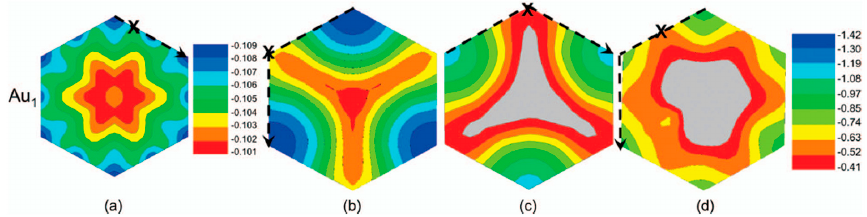
Figure 5. Potential energy surfaces for Au 1 on the (3 × 3) surfaces: ( a ) freestanding graphene; ( b ) graphene on fcc Ru(0001); ( c ) graphene on hcp Ru(0001); and ( d ) graphene on ridge Ru(0001). The hexagon identifies the standard graphene hexagon. In each image, the dashed line signs the adatom minimum-energy diffusion path. “X” marks the transition state from a local minimum energy site to another. The energy scale is in eV. Reproduced from Reference [99] with permission from the American Institute of Physics.